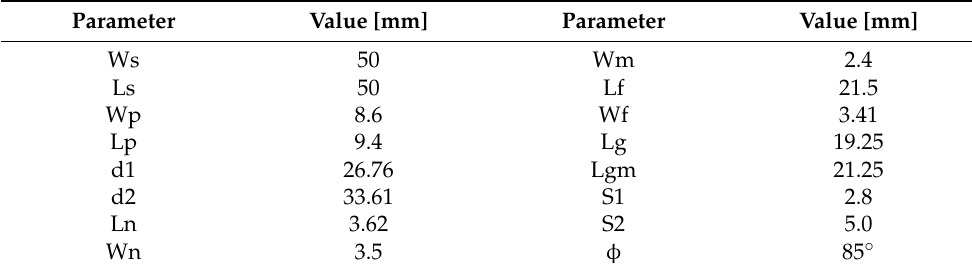
Figure 4. Geometry of the modified UWB antenna array: ( a ) top view, ( b ) bottom view. Table 2. Design parameters of modified UWB antenna array.